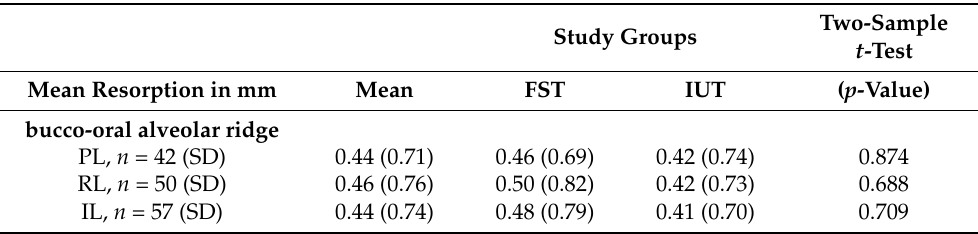
Table 4. Mean resorption of bucco-oral alveolar ridge bone width and buccal lamella bone plate from T1 to